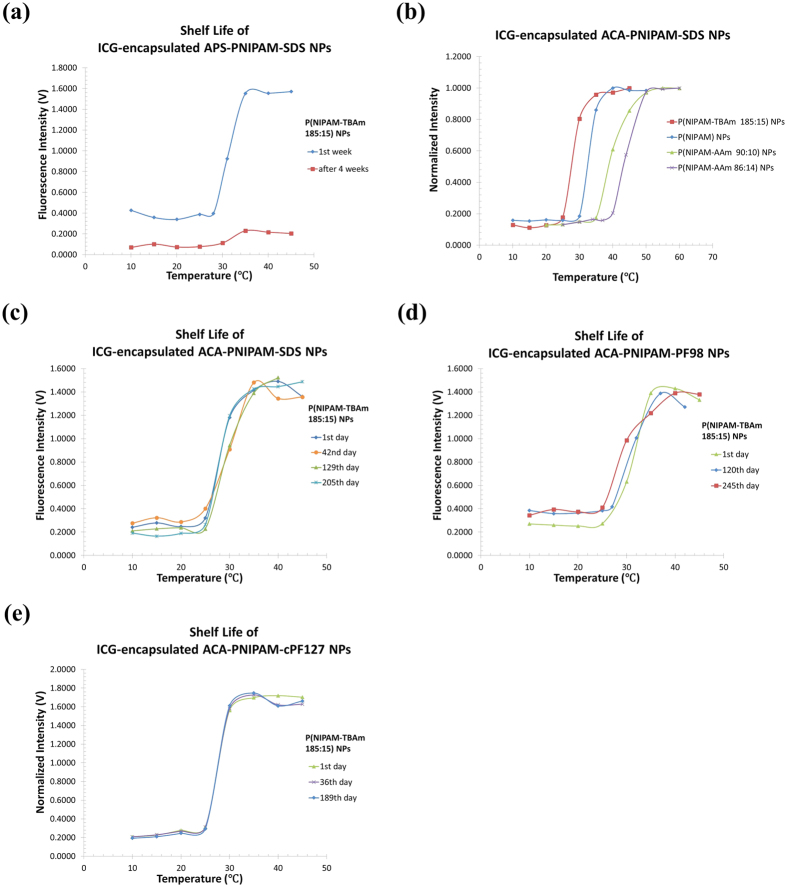
(a) Fluorescence intensity of the ICG-encapsulated APS-PNIPAM-SDS NPs nanoparticles as a function of temperature at different days (the 1st day and over 4 weeks) after the synthesis. (b) Normalized fluorescence intensity of the four ICG-encapsulated ACA-PNIPAM-SDS NPs with four LCSTs as a function of temperature. (c) Fluorescence intensity of the ICG-encapsulated ACA-P(NIPAM-TBAm 185:15)-SDS NPs as a function of temperature at different days (the 1st day, 129th day and 205th day) after the synthesis. (d) Fluorescence intensity of the ICG-encapsulated ACA-P(NIPAM-TBAm 185:15)-PF98 NPs as a function of temperature at different days (1st day, 120th day and 245th day) after the synthesis. (e) Fluorescence intensity of the ICG-encapsulated ACA-P(NIPAM-TBAm 185:15)-cPF127 NPs as a function of temperature at different days (1st day, 36th day and 189th day) after the synthesis.